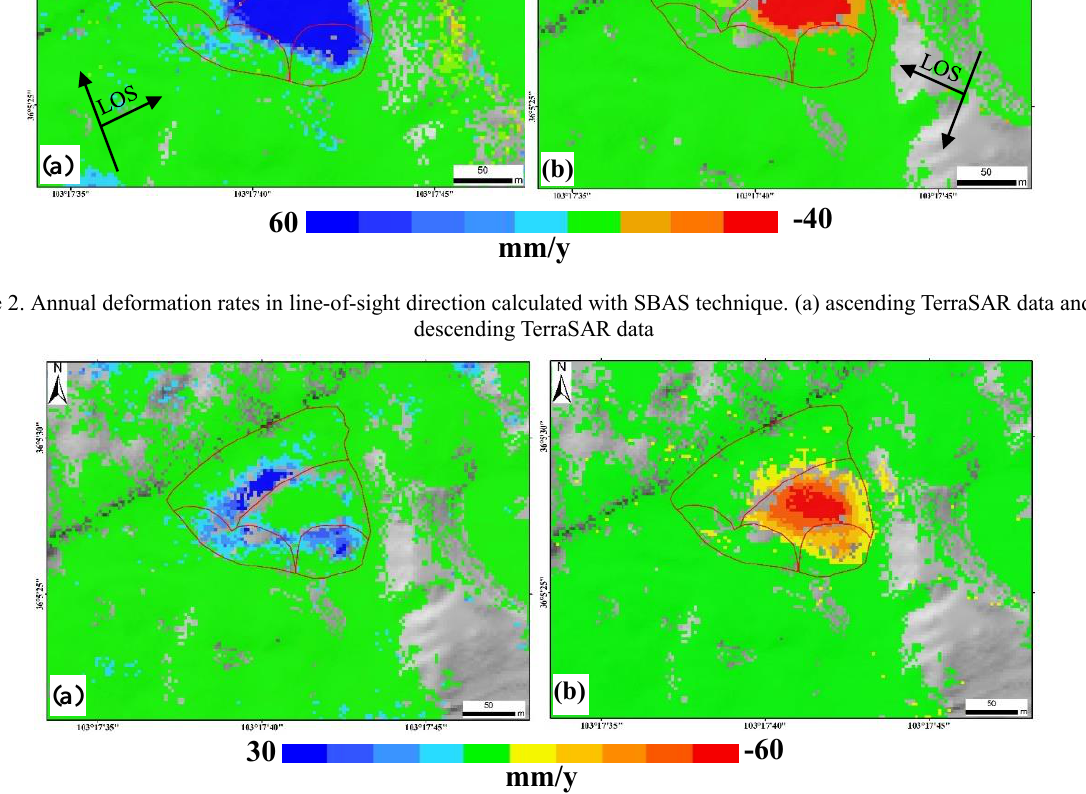
Figure 3. Annual deformation rates calculated with MSBAS technique. (a) in vertical direction and (b) in east-west